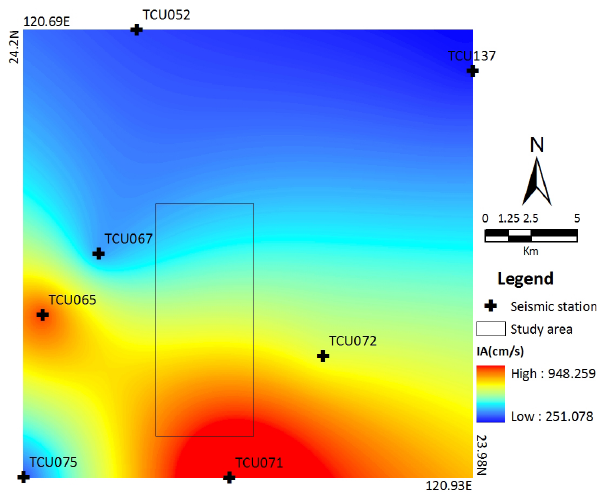
Fig. 5. Arias intensity generated by interpolating the shaking intensity recorded at a seismic